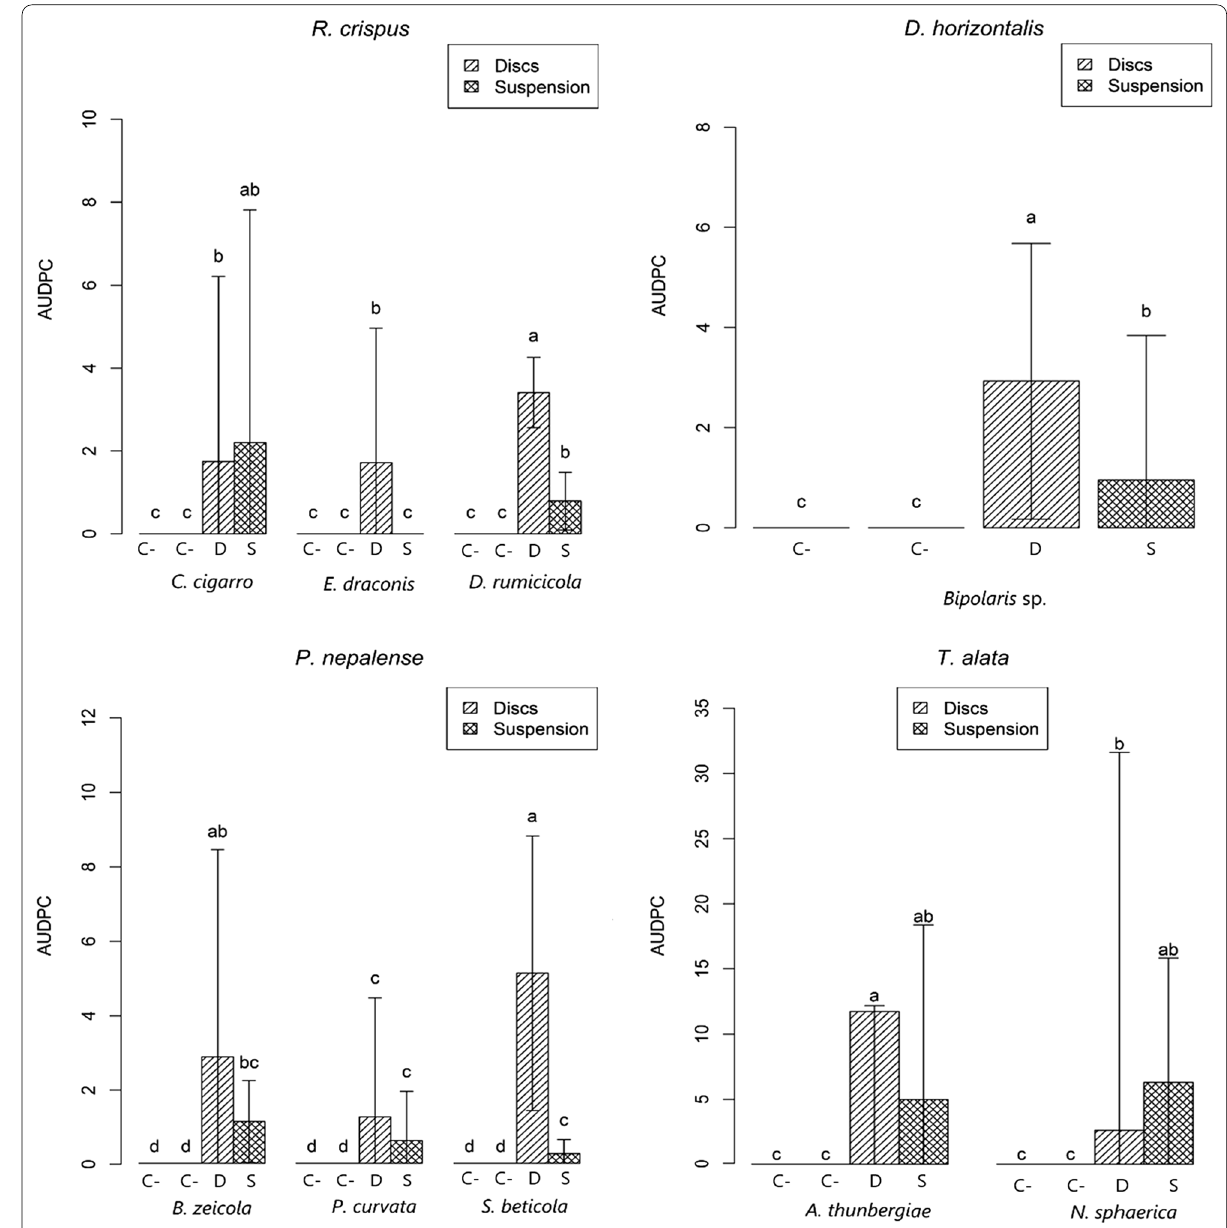
Fig. 1 Area under disease progress curve (AUDPC) [cm 2 /10 days] of pathogenic fungal isolates of Rumex crispus, Digitaria horizontalis, Persicaria nepalensis, and Thunbergia alata. Pathogenicity tests were performed on detached leaves using two inoculation methods. AUDPC averages were calculated based on four repetitions per treatment and three replicates of the experiment over time. Different letters indicate significant differences between treatments, identified by the Kruskal Wallis and, Wilcolxon Test (p <